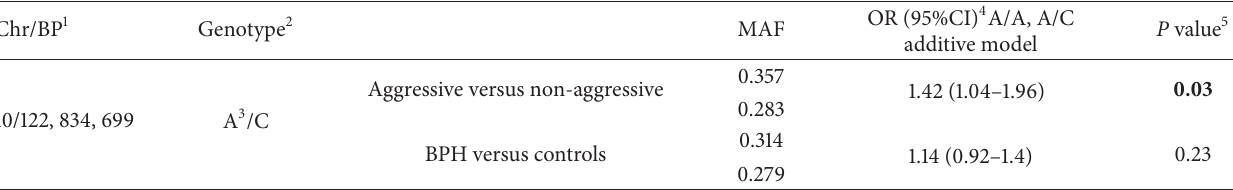
Table 2: Association results for rs2252004 and BPH aggressiveness/risk.